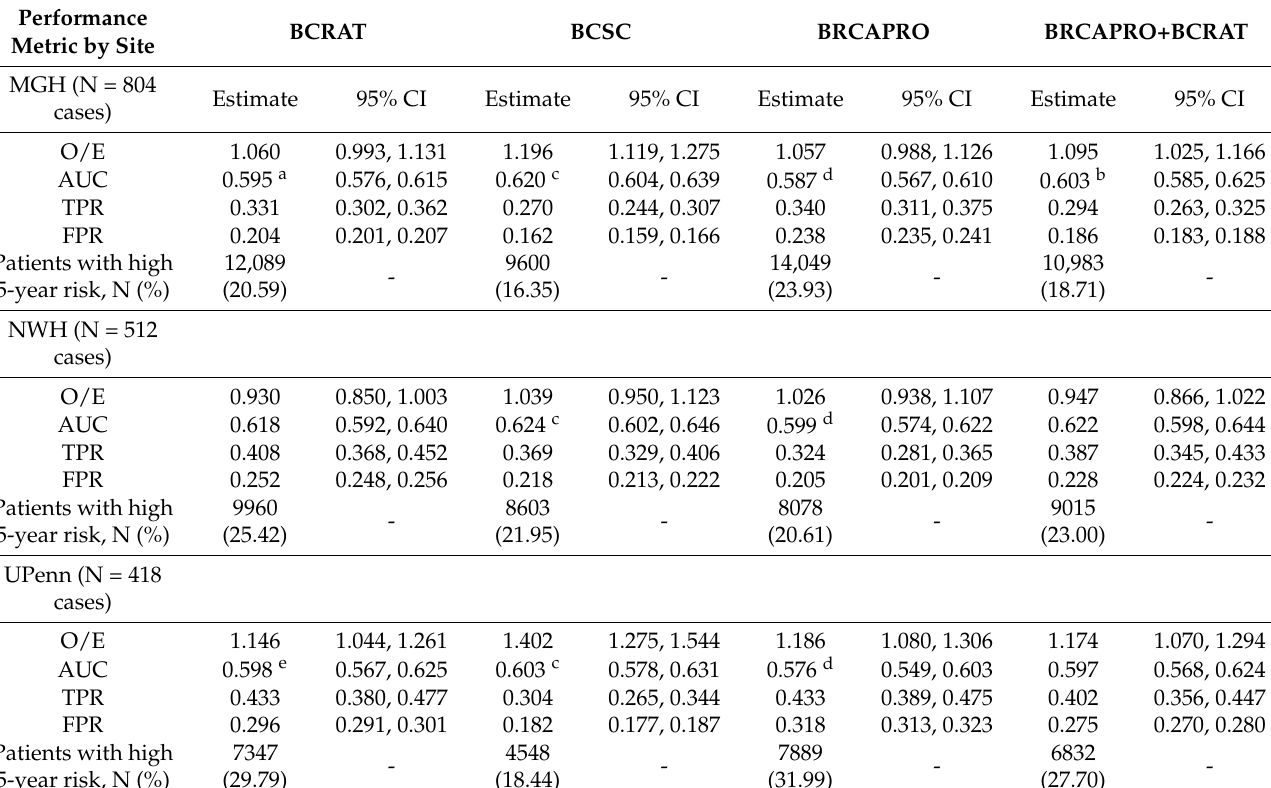
Table A1. Performance of risk models by